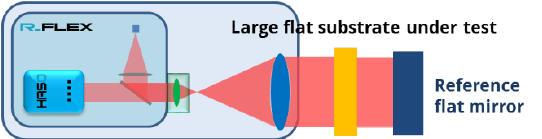
Fig. 2. Setup of the optical characterization of a large flat glass (yellow slab) with a Shack Hartmann wavefront sensor